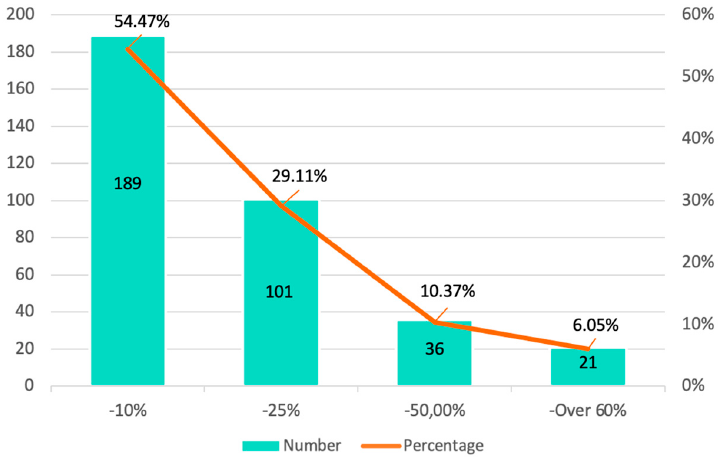
Figure 3. Decrease in the number of patients.